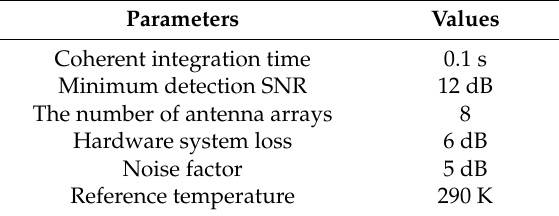
Table 2. The Other System Parameters of Two Frequency Networks.